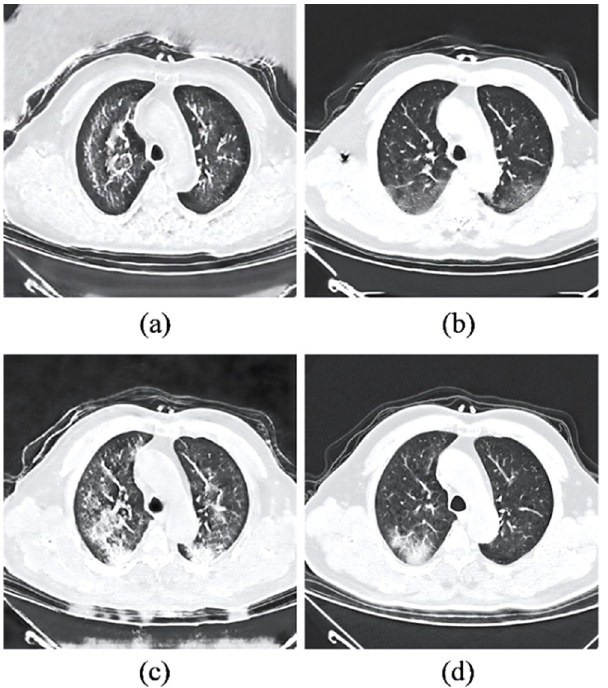
Figure 15. Examples of synthetic COVID-19 images generated from ( a ) GAN (without both cycle and pixel consistency loss, ( b ) GAN + pixel consistency, ( c ) CycleGAN (without pixel consistency), and ( d ) CycleGAN + pixel consistency.